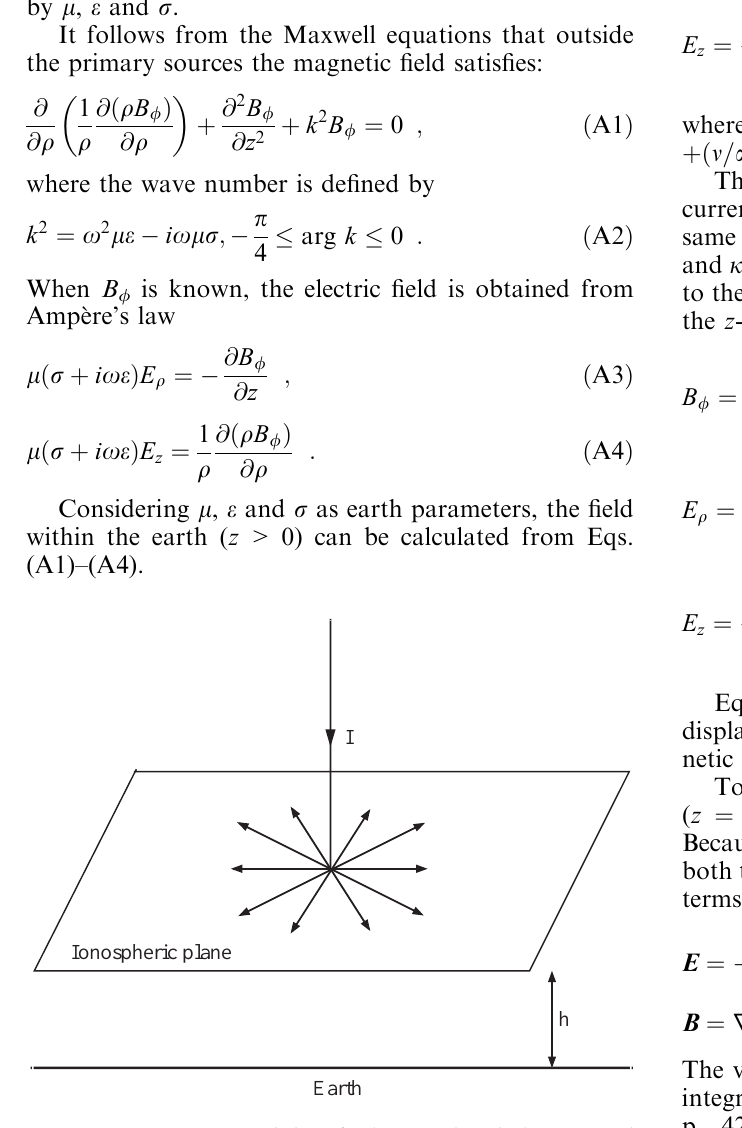
Fig. 5. Current system consisting of a downward vertical current and a radial horizontal current distribution at the height h above the earth’s